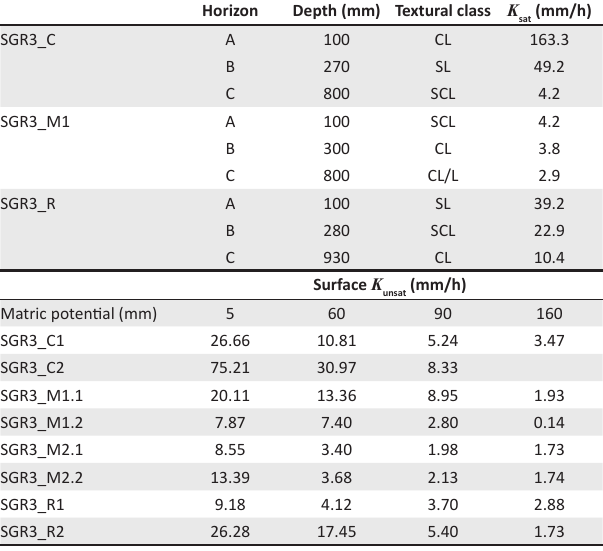
TABLE 4: Soil texture and hydraulic property characteristics for the third-order hillslope.